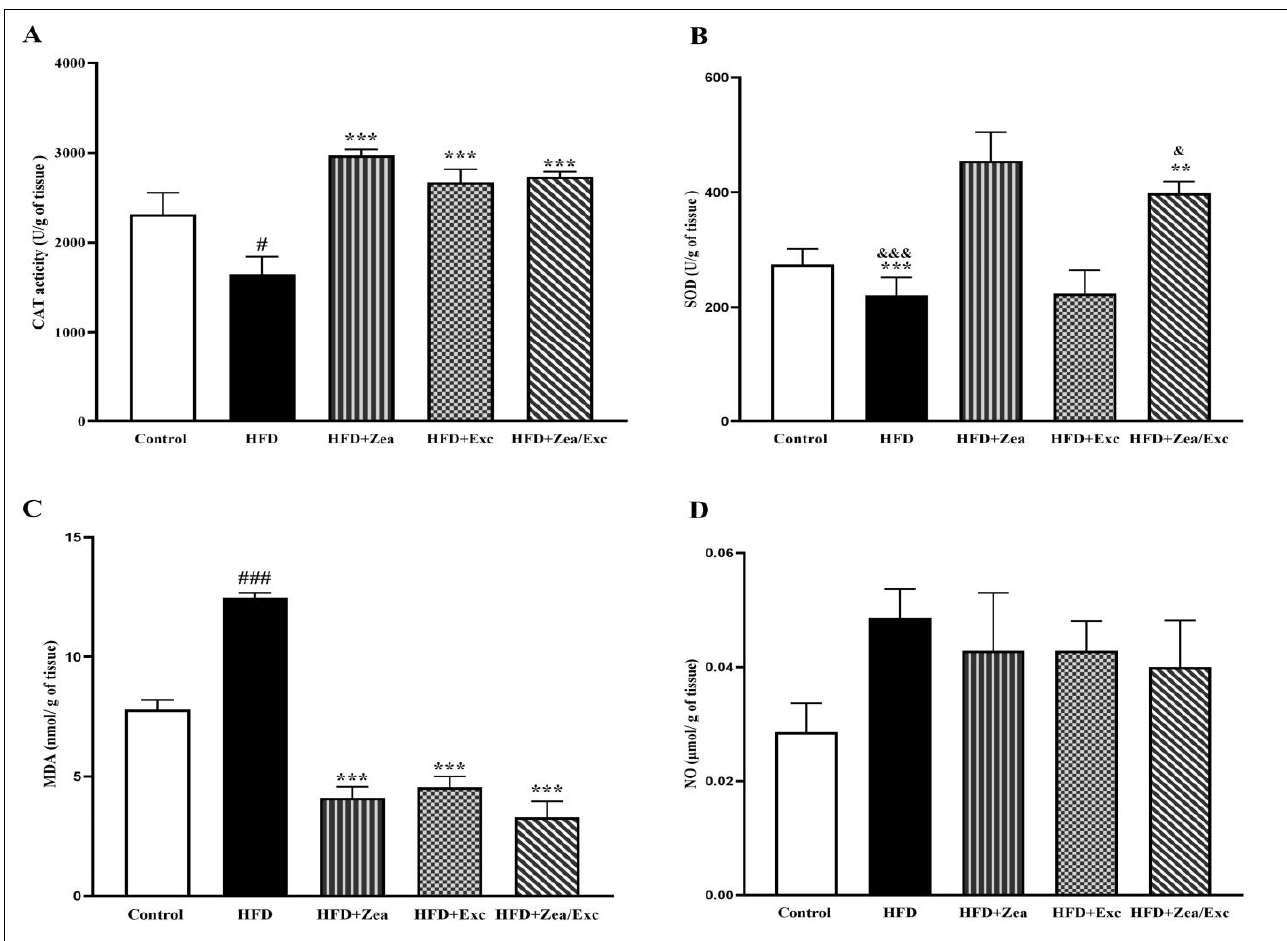
Figure 6. Effects of Zea and Exc on hepatic tissue oxidative stress and antioxidant markers in HFD-induced obese rats. ( A ) Catalase (CAT); ( B ) superoxide dismutase (SOD); ( C ) malondialdehyde (MDA); ( D ) nitric oxide (NO). Data are expressed as means ± SEM, n = 7. # p < 0.05, ### p < 0.001 vs. control; ** p <0.01, *** p <0.001 vs. HFD; & p < 0.05, &&& p < 0.001 vs. HFD + Exc.